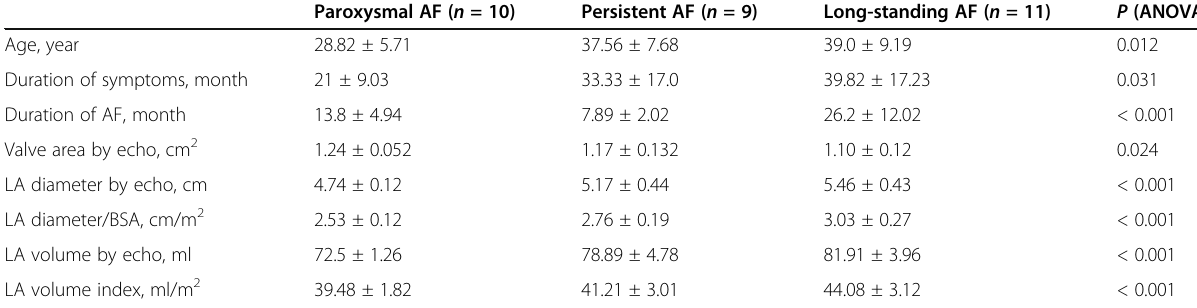
Table 5 Comparison between types of AF regarding demographic and echocardiographic